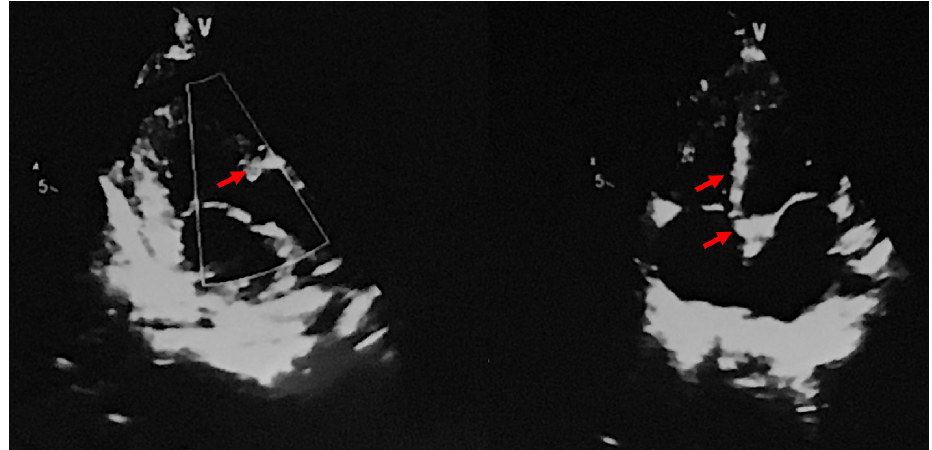
Figure 3: Echocardiogram revealed the rhabdomyoma that compromised interventricular septum, left ventricle and aortic valves (red arrow).